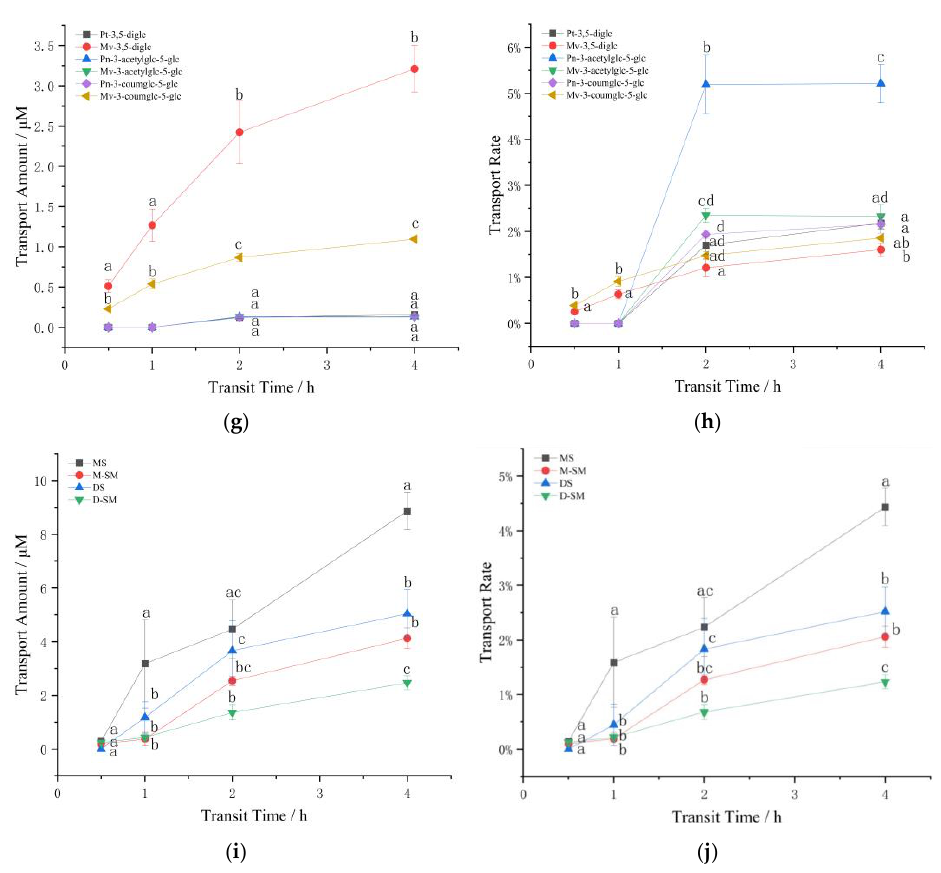
Figure 2. Changes in the transport amount and transport rate of the anthocyanins. ( a ) The transport amount of 100 µ M monoglycoside mixture; ( b ) The transport rate of 100 µ M monoglycoside mixture; ( c ) The transport amount of 200 µ M monoglycoside mixture; ( d ) The transport rate of 200 µ M monoglycoside mixture; ( e ) The transport amount of 100 µ M disaccharide mixture; ( f ) The transport rate of 100 µ M disaccharide mixture; ( g ) The transport amount of 200 µ M disaccharide mixture; ( h ) The transport rate of 200 µ M disaccharide mixture; ( i ) The transport amounts of standard anthocyanins; ( j ) The transport rate of standard anthocyanins. Different small letters indicate significant difference at p < 0.05 in each figure. MS: monoglycoside standard; DS: diglycoside standard; M-: the transport information of monoglycosides; D-: the transport information of diglycosides; SM: standard mixture of monoglycoside and